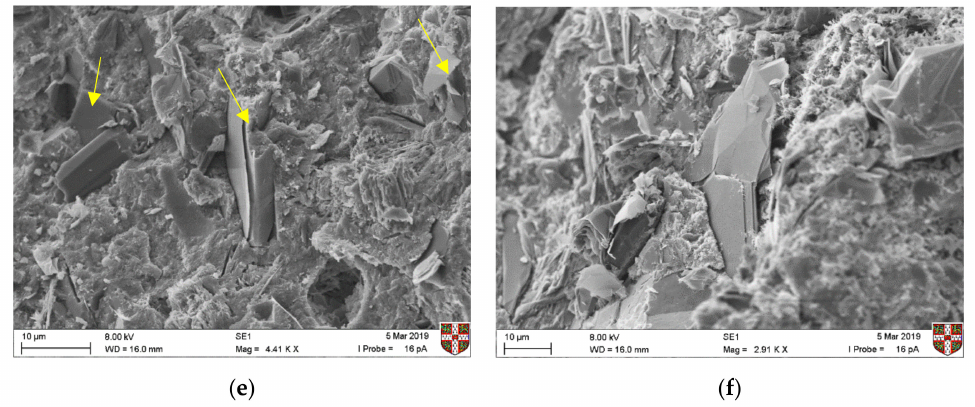
Figure 4. Microstructural characterization of the three graphites-cement paste after ~5 months by SEM